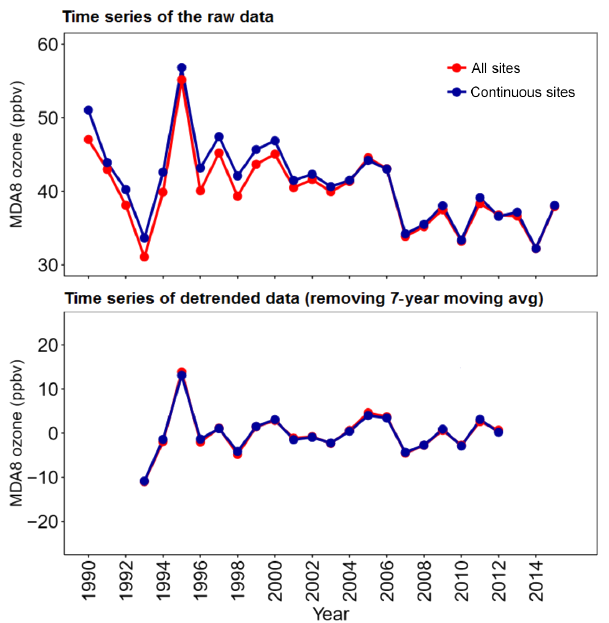
Figure 2. Summer (JJA)-mean ozone over the HGB area during the period from 1990 to 2015. The upper panel is the time series of the raw data and the lower panel is the detrended time series after subtracting the 7-year moving averages. The red line is the average from all available sites for each year and the blue line is the average of those sites with continuous coverage from 1990 to